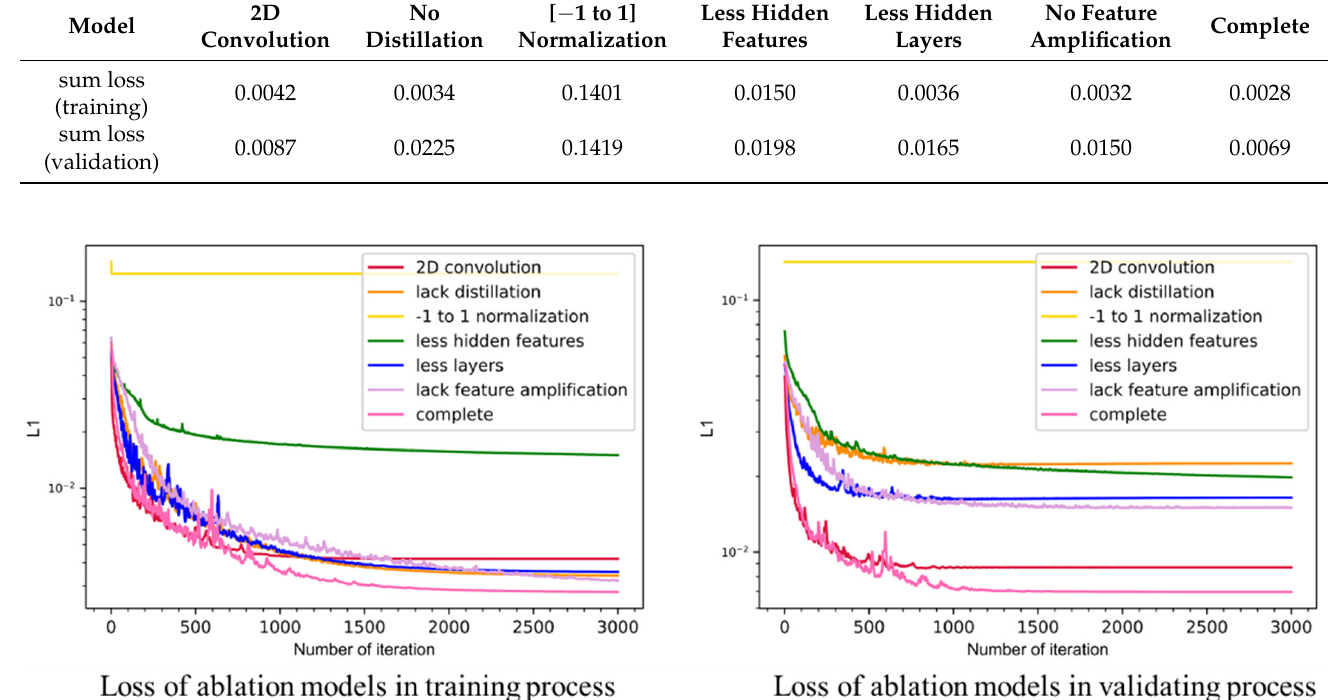
Figure 10. The loss of multiple models in the training stage and validating stage. Table 2. The training loss of the complete model and 5 incomplete model.